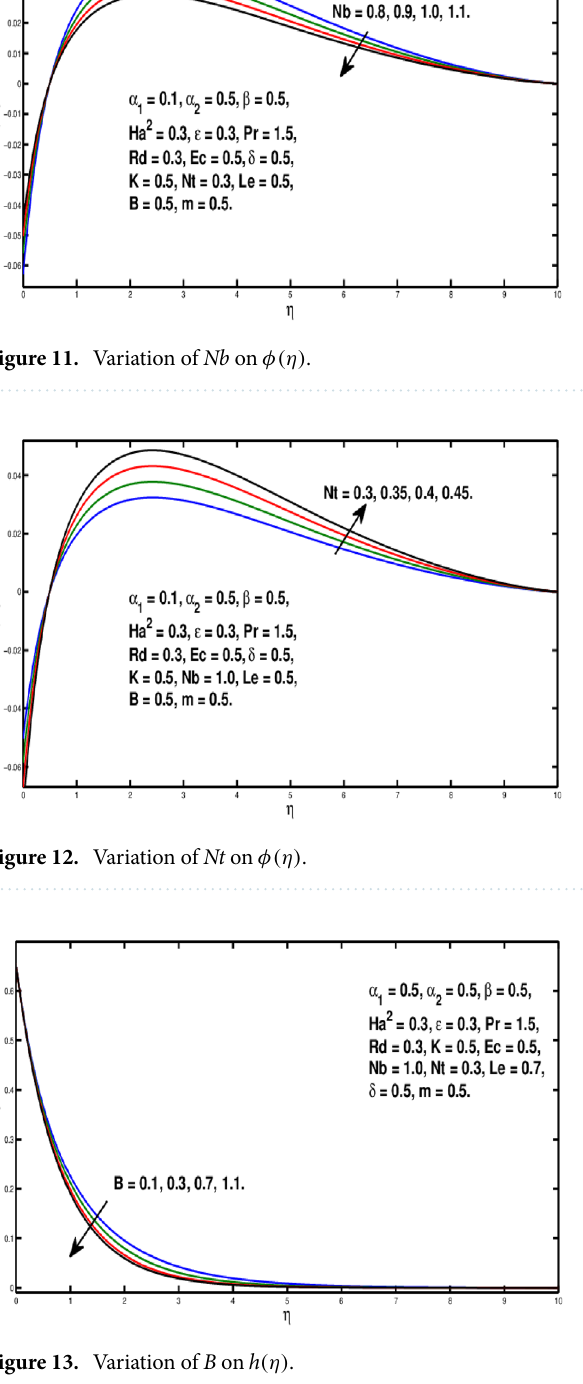
Figure 13. Variation of B on h (η)